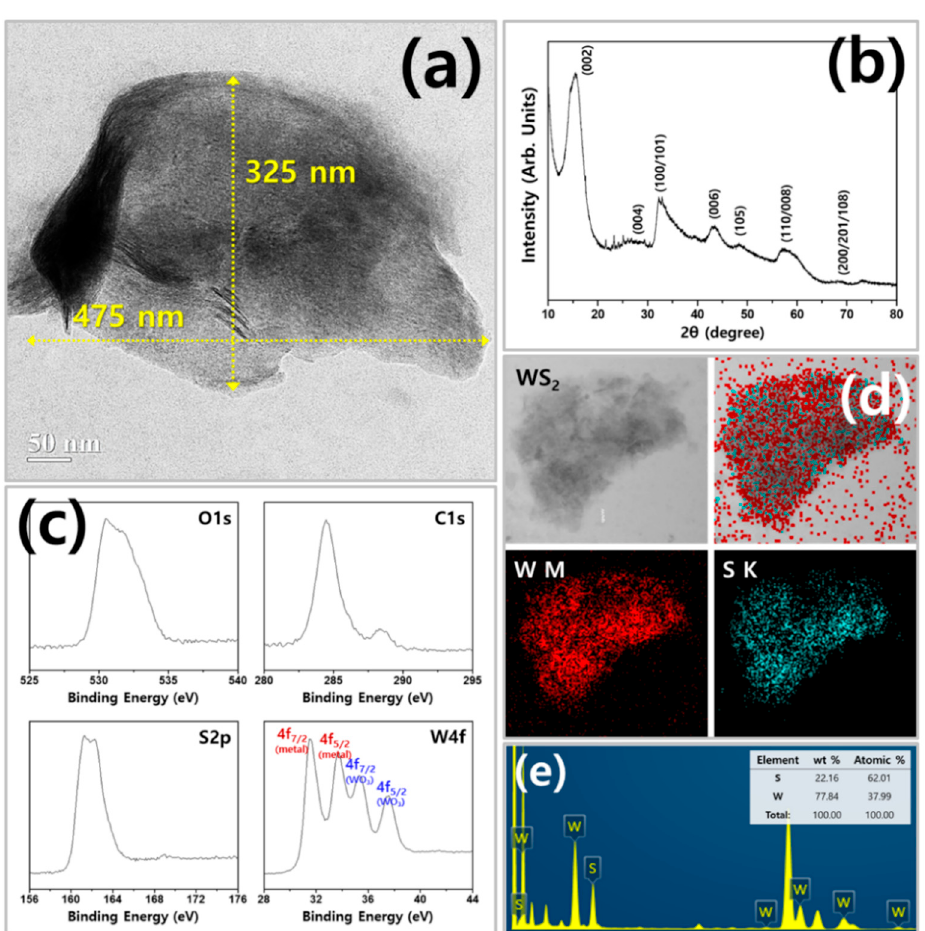
Figure 1. ( a ) High resolution (HR)-TEM image of monolayer WS 2 . ( b ) XRD spectrum of monolayer WS 2 . ( c ) XPS spectrum of monolayer WS 2 . ( d ) EDS elemental mapping (W and S) of monolayer WS 2 . Table 1. Summary of the estimated piezo-coefficient 2D materials.